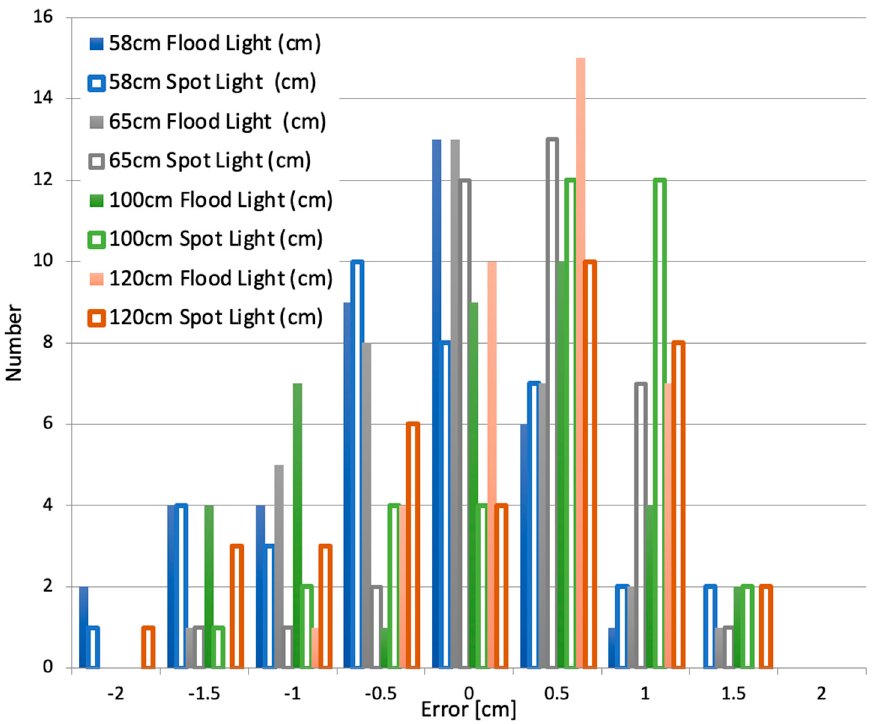
Figure 19. Distribution of errors of measurement.